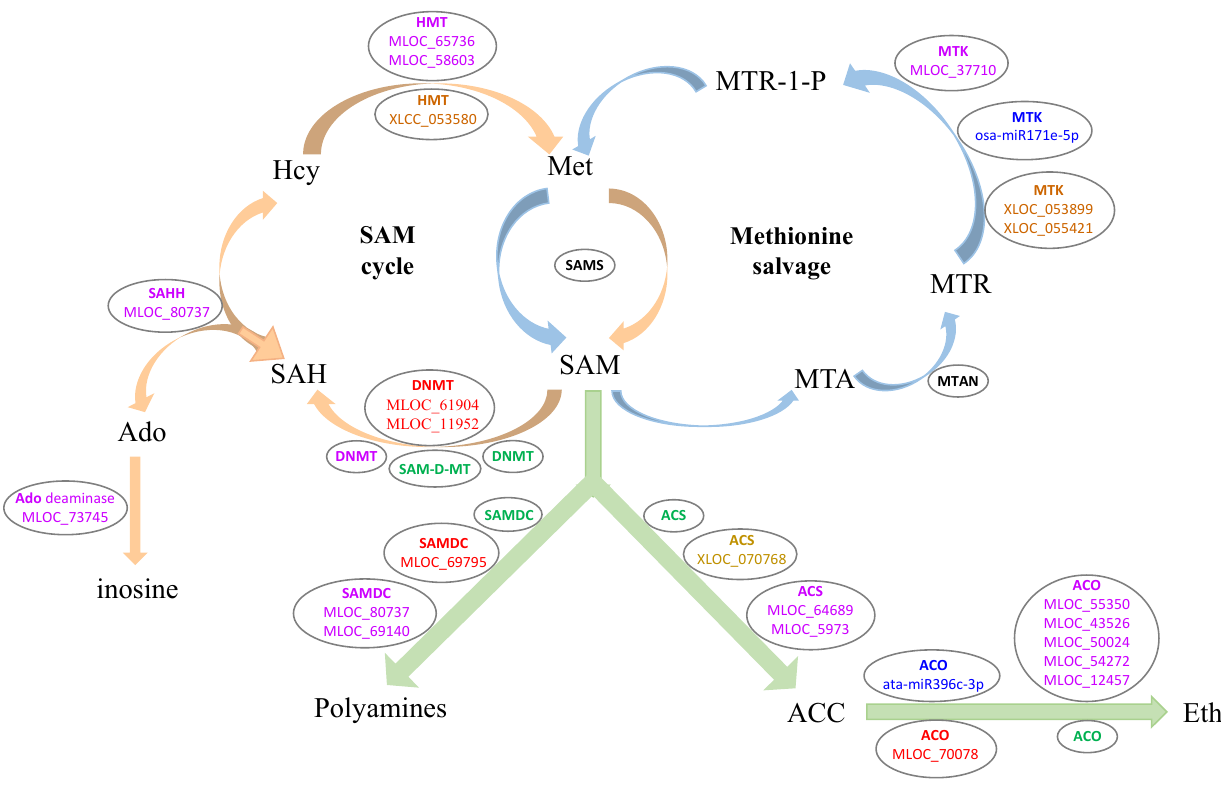
‘normal’ presented in the table means without significant gene expression in this study.